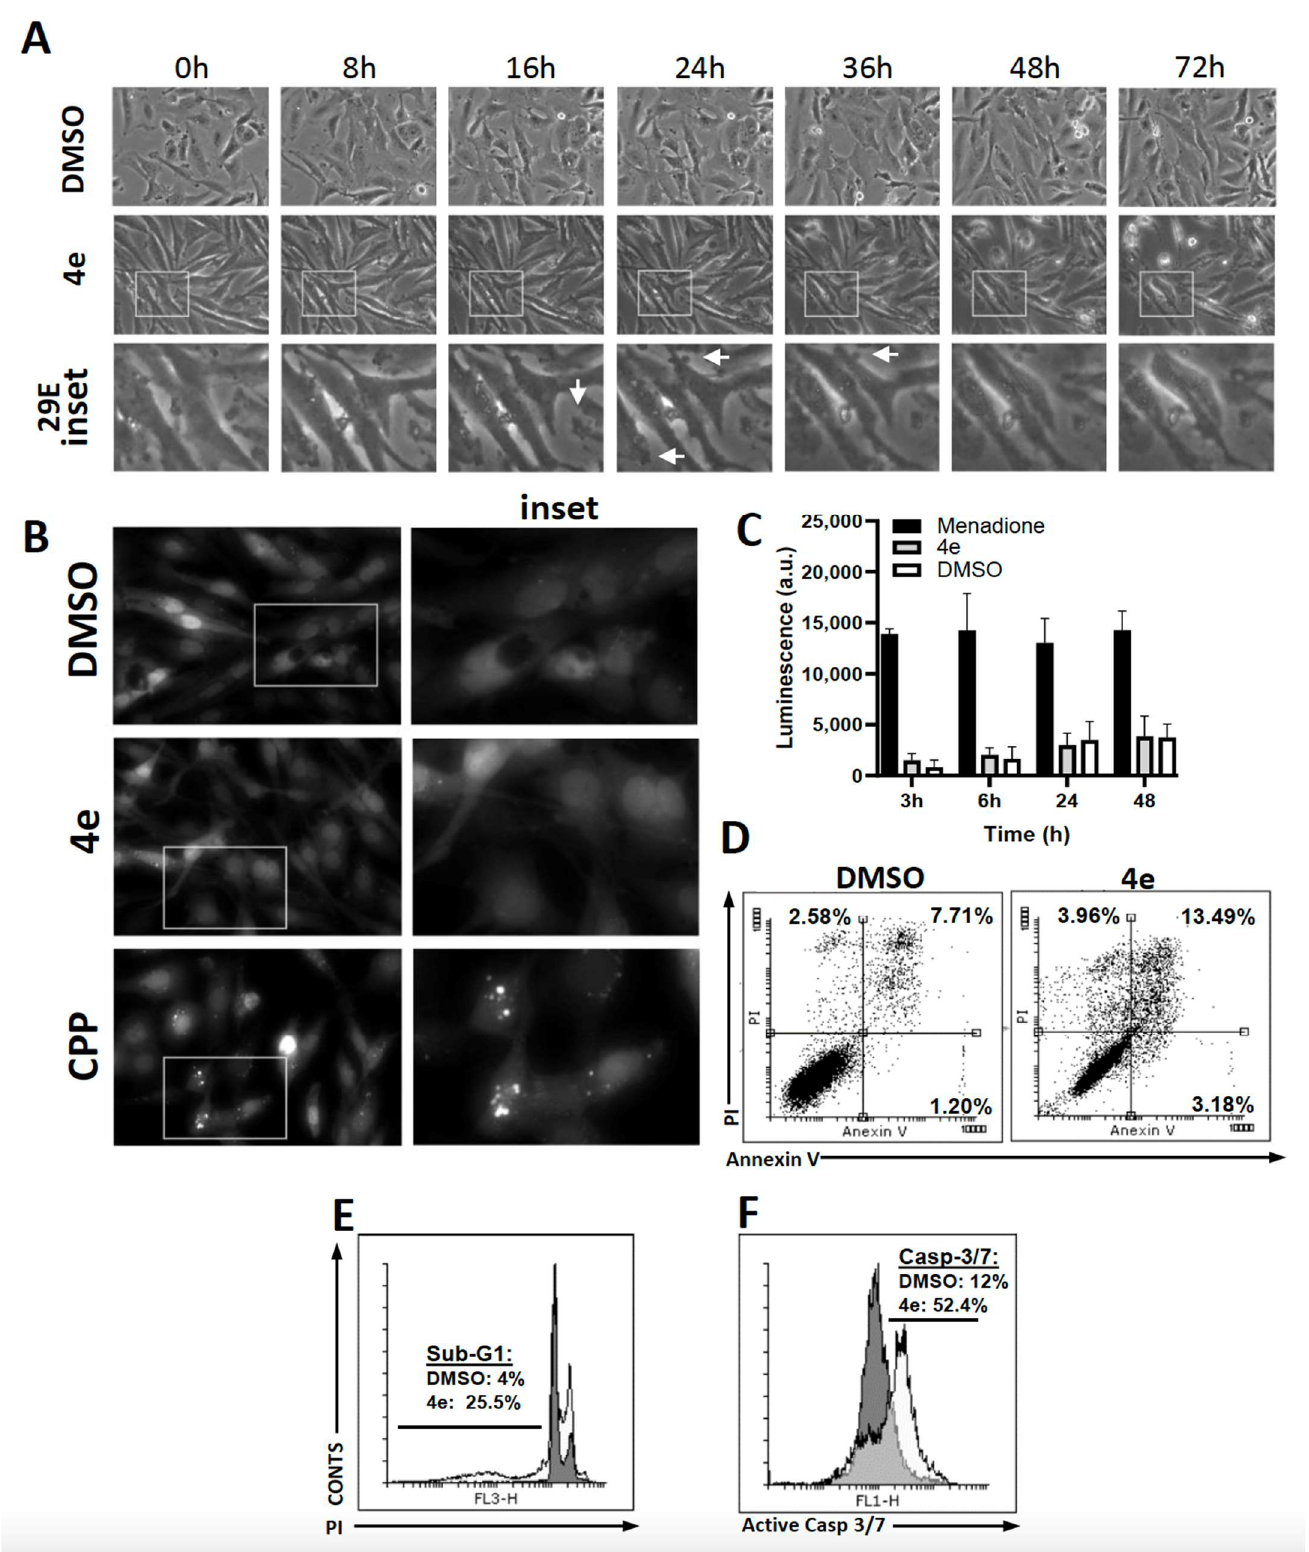
Figure 6. Cell death mechanism investigation for the most selective naphthoquinone derivative 4e in OSCC cells. All experiments were performed using SCC9 cells. ( A ) Time-lapse video microscopy images obtained from Supplementary Video S1 reveal that 4e (2 × IC 50 ) induces the appearance of membrane blebs, the loss of membrane integrity, and cellular rupture, which were intensified at 36 and 48 h. The same result was not observed for the DMSO control. ( B ) Determination of